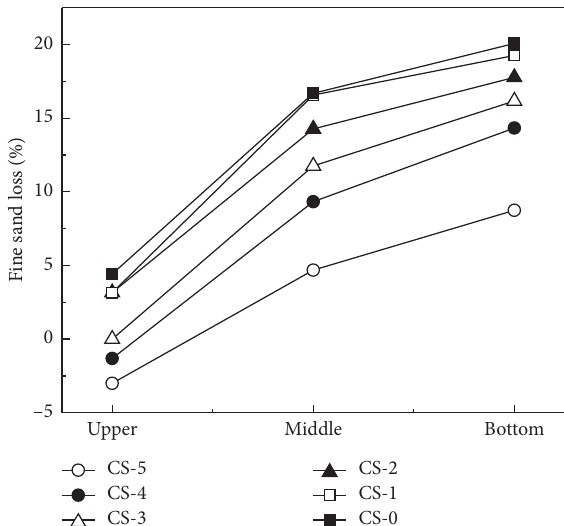
Figure 14: Percentage of fine sand loss for the CS group.